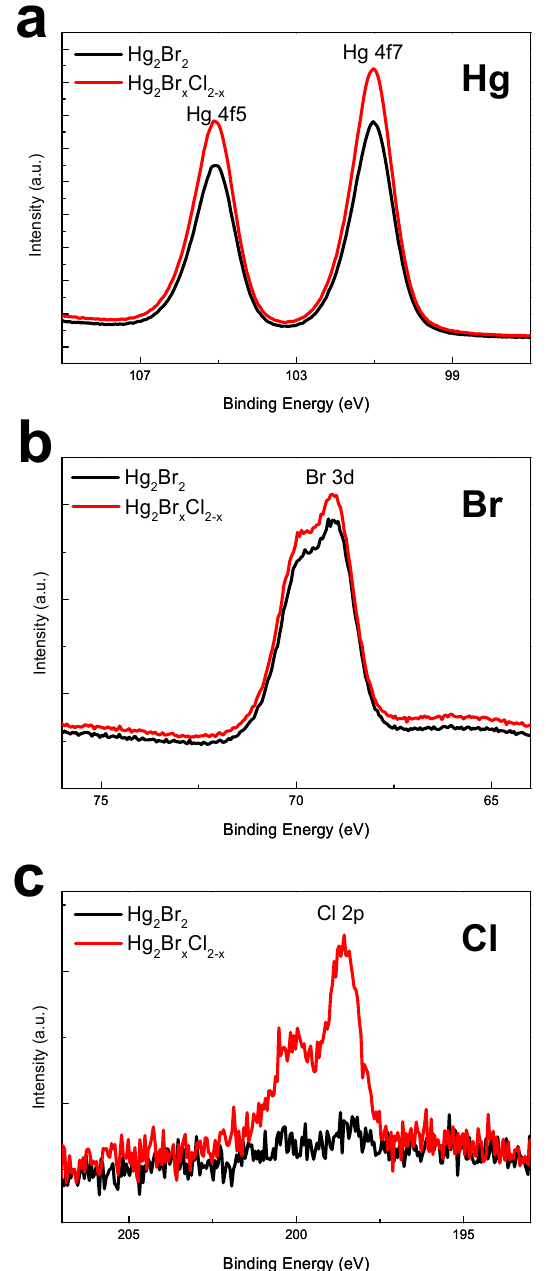
Figure 4. Narrow-scan X-ray photoelectron spectra of ( a ) Hg 4f, ( b ) Br 3d, and ( c ) Cl 2p for Hg 2 Br 2 and Hg 2 Br x Cl 2 − x crystals.